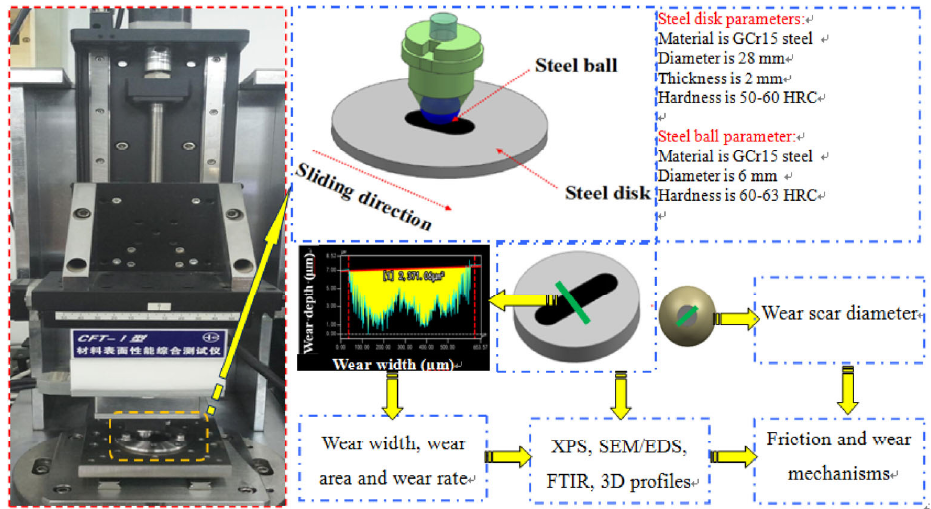
Fig. 1 Schematic diagram of the tribo-meter and analysis